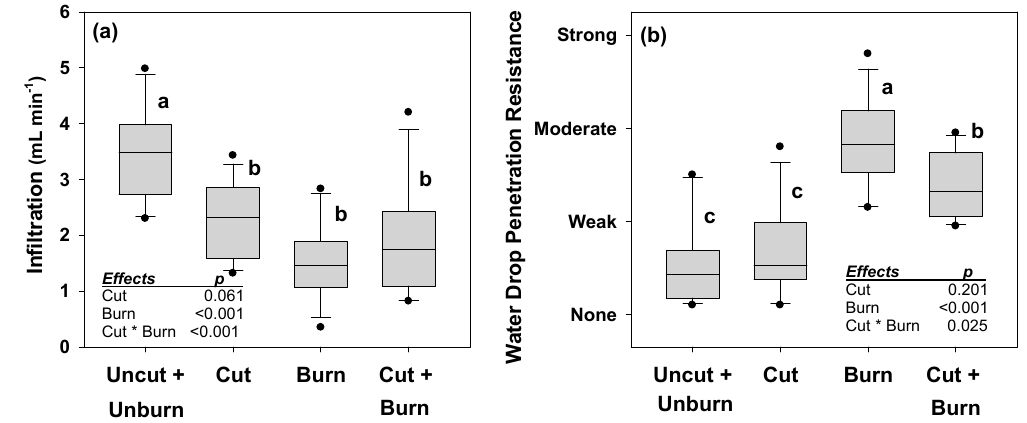
Figure 6. Water infiltration rate ( a ) and water drop penetration resistance ( b ) measured in 2012 after logging and the Church’s Park Fire in mountain pine beetle-infested stands. Plots show 25th, 50th and 75th percentiles (box), 10th and 90th percentiles (whiskers) and outliers (filled circles). Different letters indicate that treatment values differ based on Tukey’s pairwise adjusted comparisons. Water drop resistance ratings as follows: none <10 s; weak 10–40 s; moderate 40–180 s; strong >180 s.